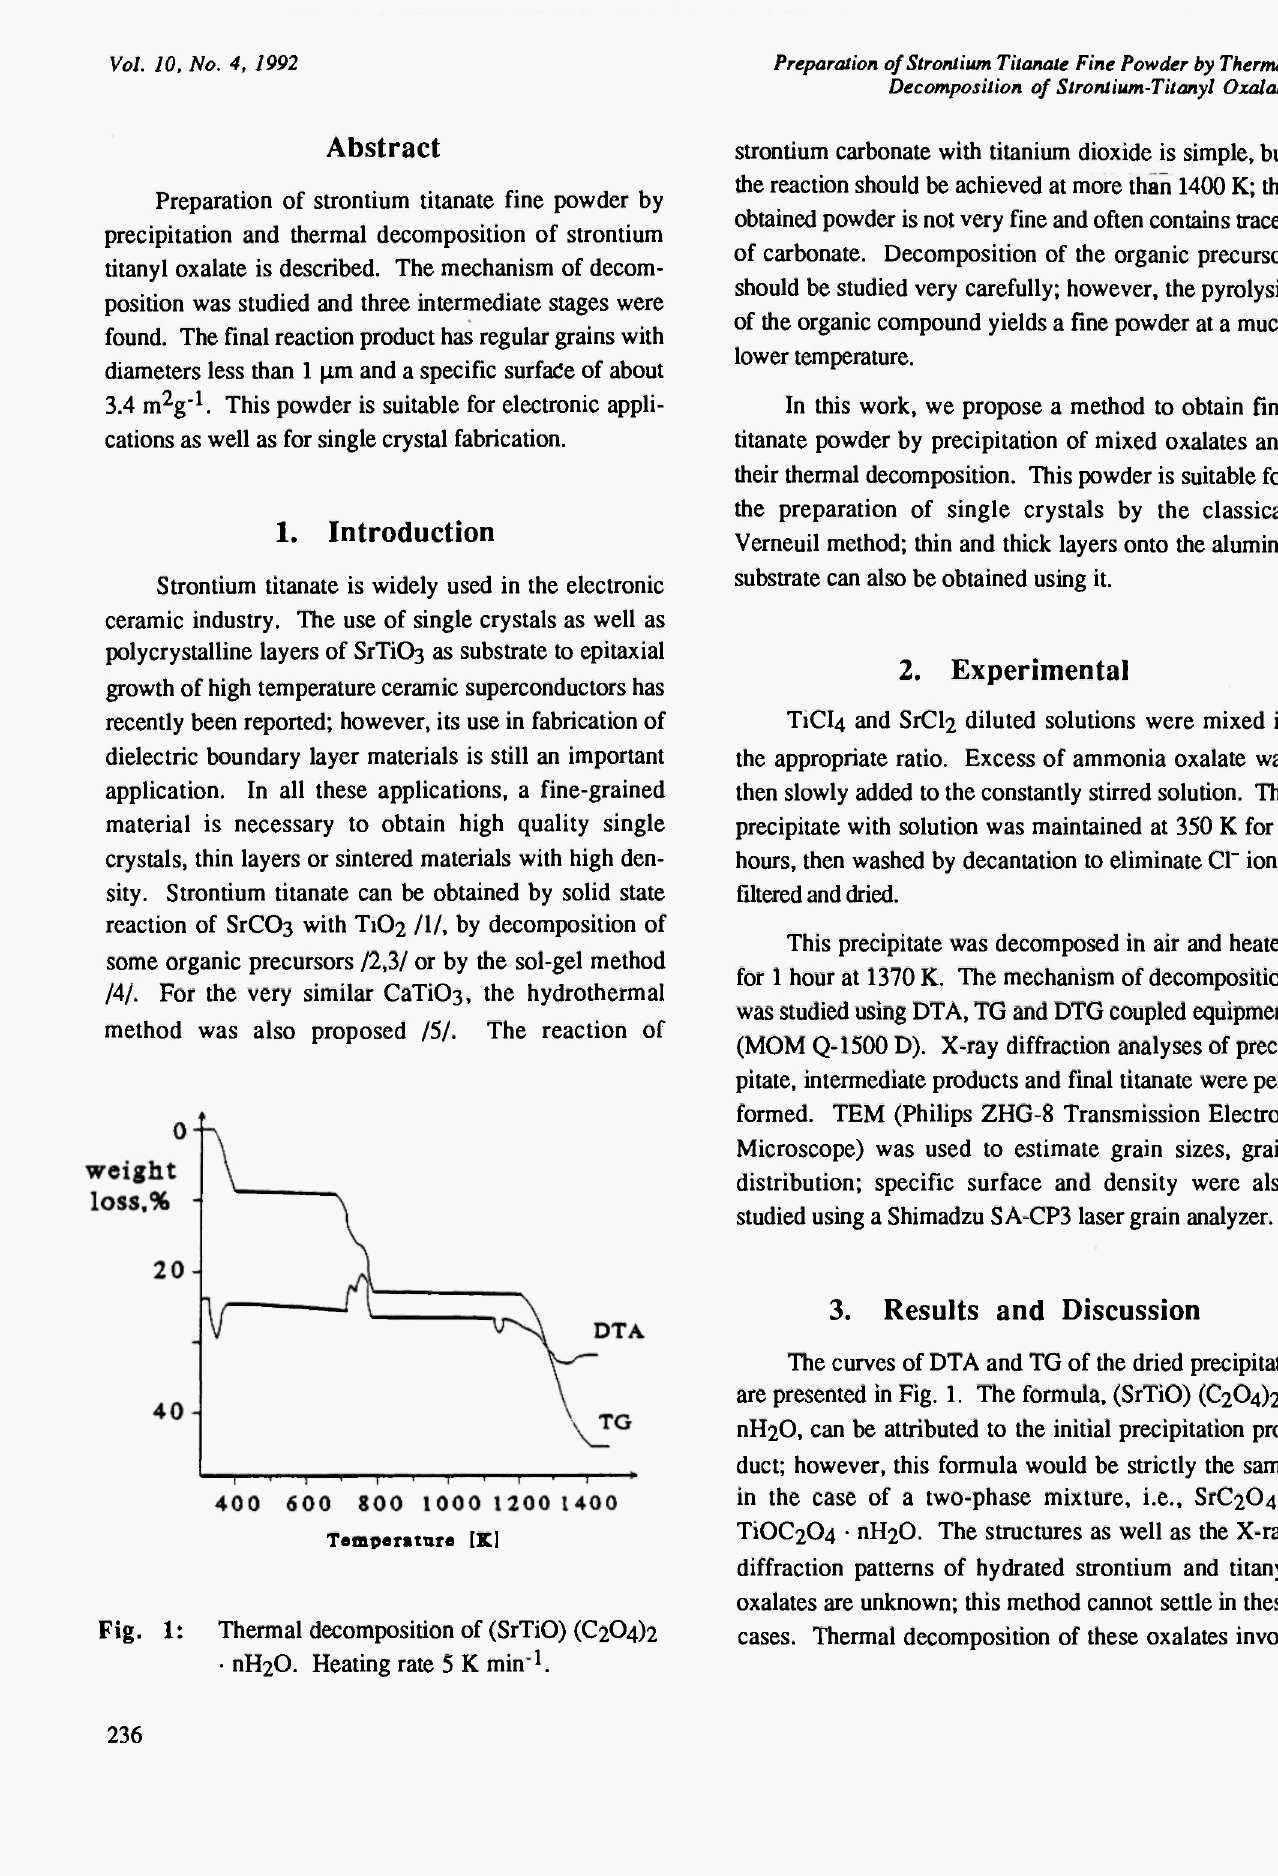
1: Thermal decomposition of (SrTiO)